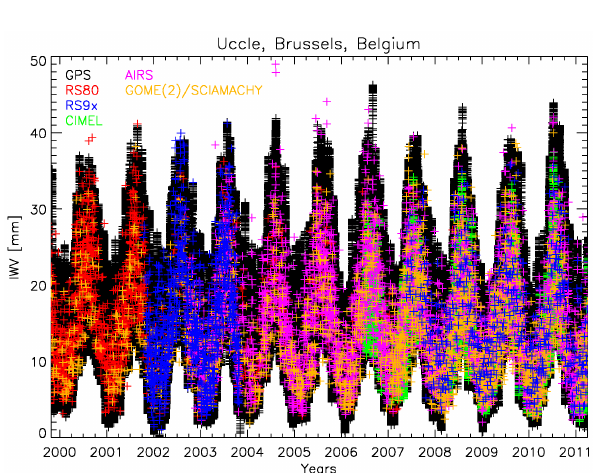
Figure 4. Overview of all IWV data available at Uccle, Brussels,